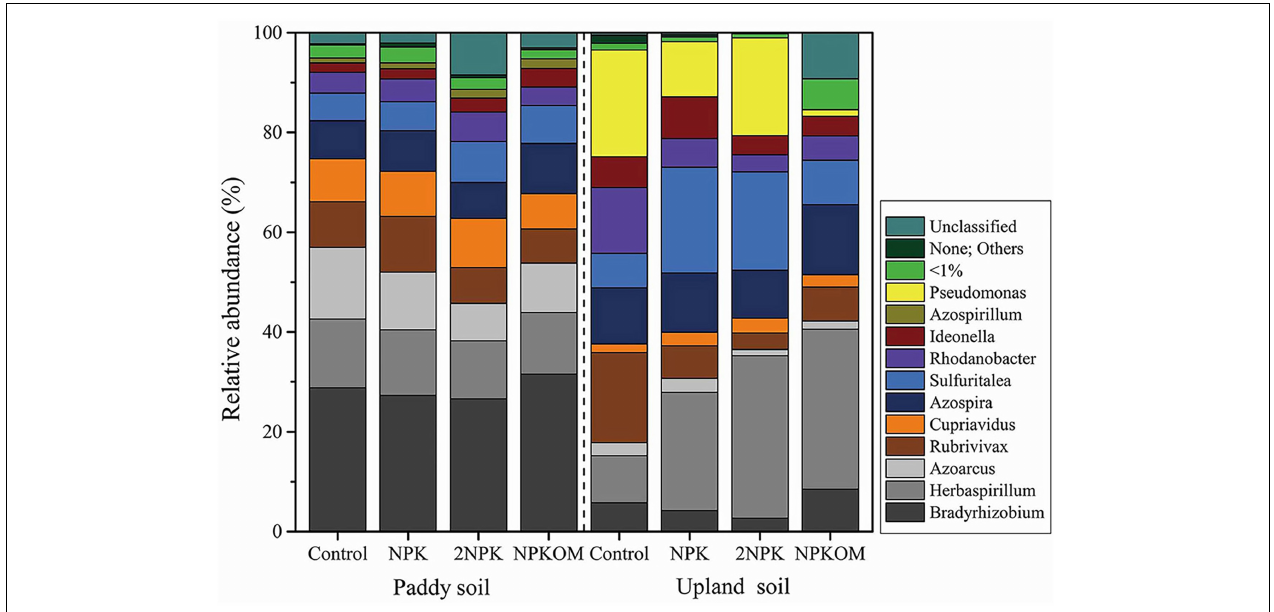
FIGURE 3 | Taxonomic composition at the genus level of the nirS -denitrifying bacterial communities in paddy soil and upland soil. None; others indicate that a large degree of nirS -type diversity is not represented in the current genome database.